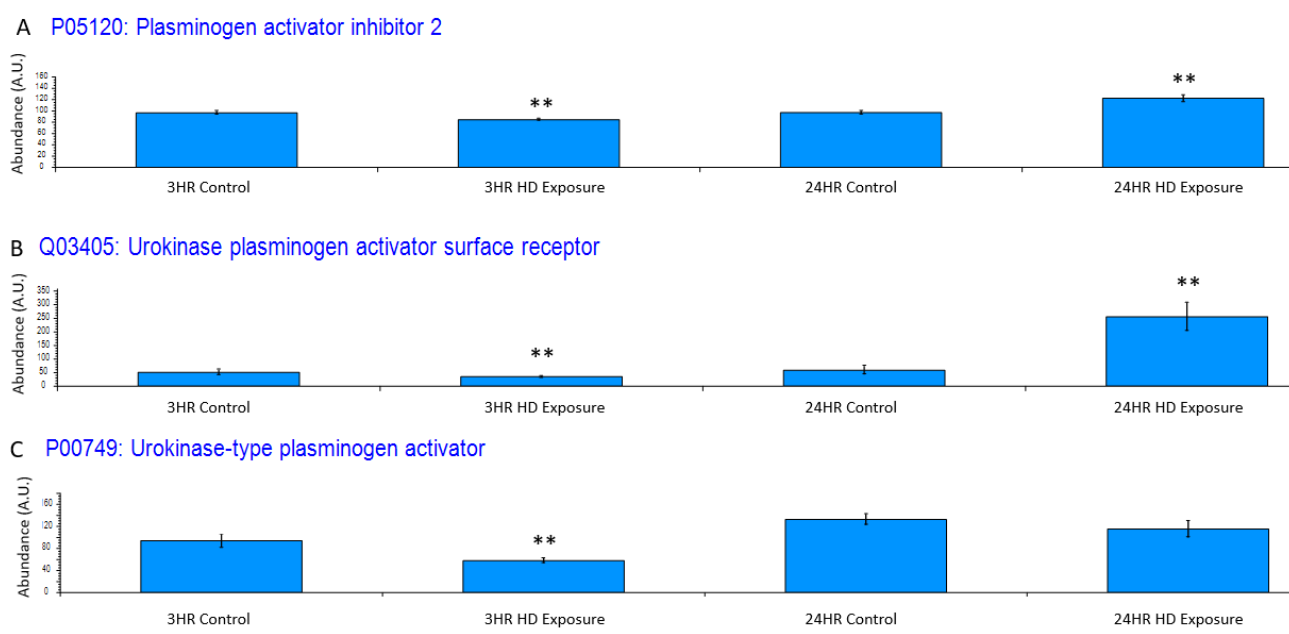
Figure 5. Bar graphs of the grouped abundances of ( A ) plasminogen activator inhibitor 2 (PAI2) ex- pression profile across the control groups and the 3 h and 24 h exposures, ( B ) Urokinase plasminogen activator surface receptor dysregulation at the 3 h and 24 h marks indicating an upregulation in recruitment of urokinase-type plasminogen activator (PLAU) at the 24 h timepoint and initial inflam- matory response at associated with the decrease in uPAR. The dysregulation appears to increase post exposure to a point of significant dysregulation, ( C ) PLAU shows increase expression indicating an inflammatory response. Significant dysregulation (adj. p -value ≤ 0.05) is shown by **. uPA also acts as a serine protease that activates matrix metalloproteinase-9